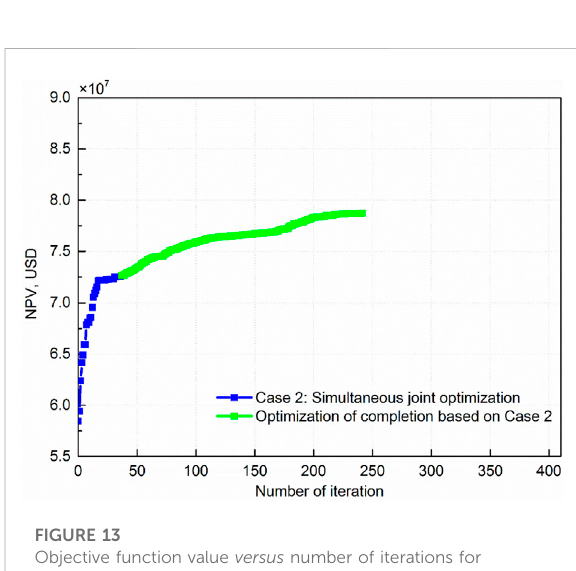
FIGURE 13 Objective function value versus number of iterations for continued optimization of completion based on Case 2.